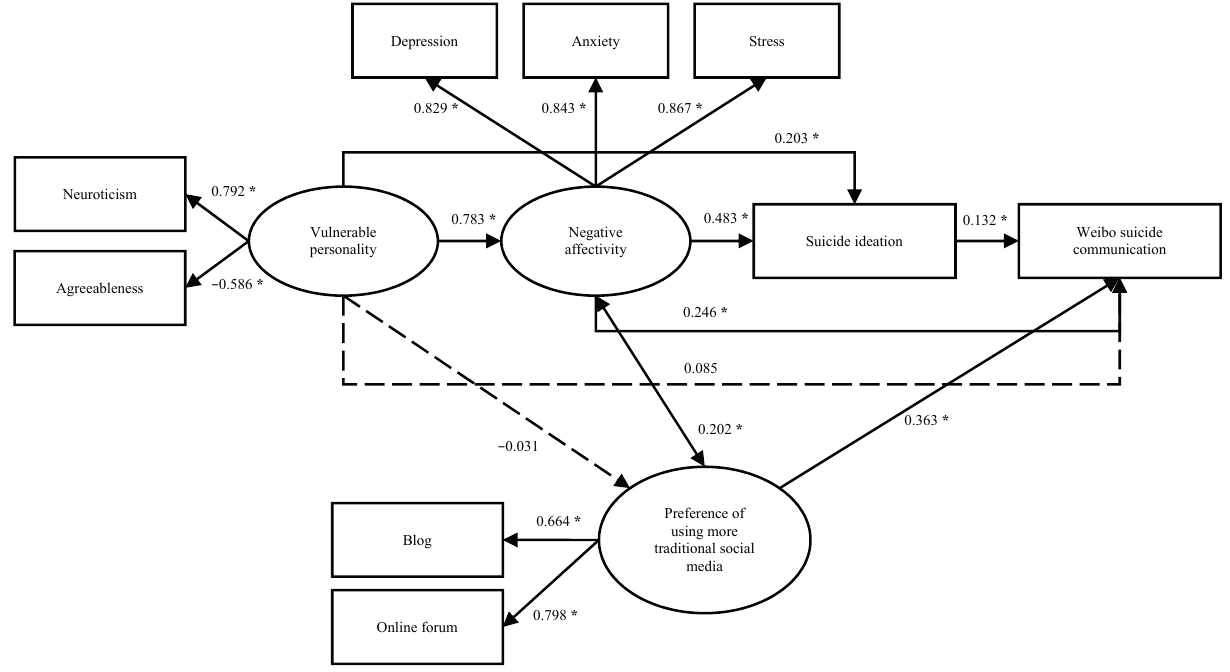
Figure 6. Results of SEM on Model 3b (age and education level were included in the model as covariates, * p <